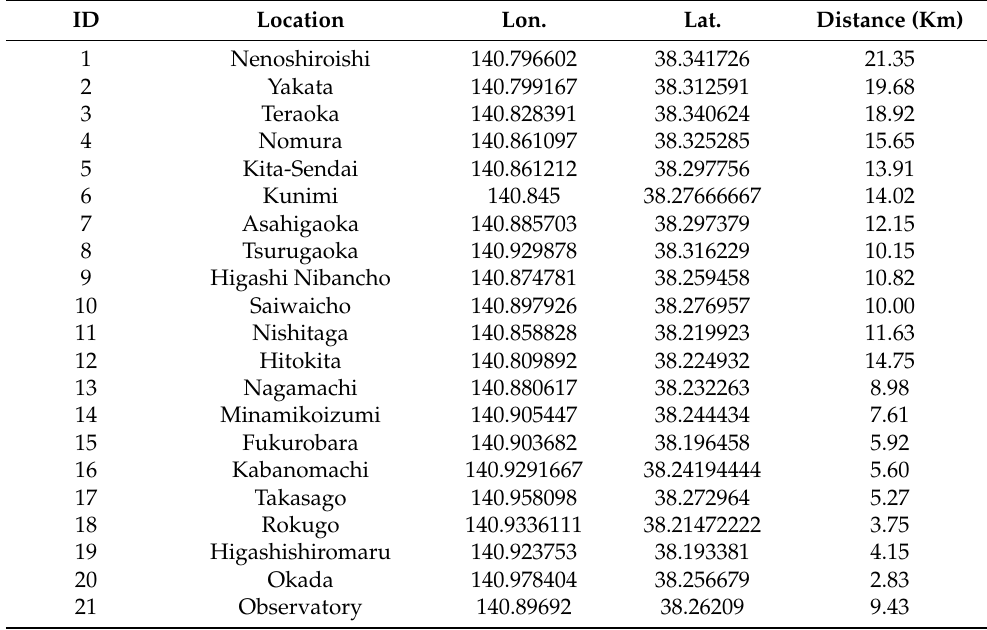
Table 1. Temperature and humidity recorder, and Sendai Local Meteorological Observatory informa- tion, including ID, name, coordinates and distance from the coast in the direction of prevailing winds. ID Location Lon. Lat. Distance